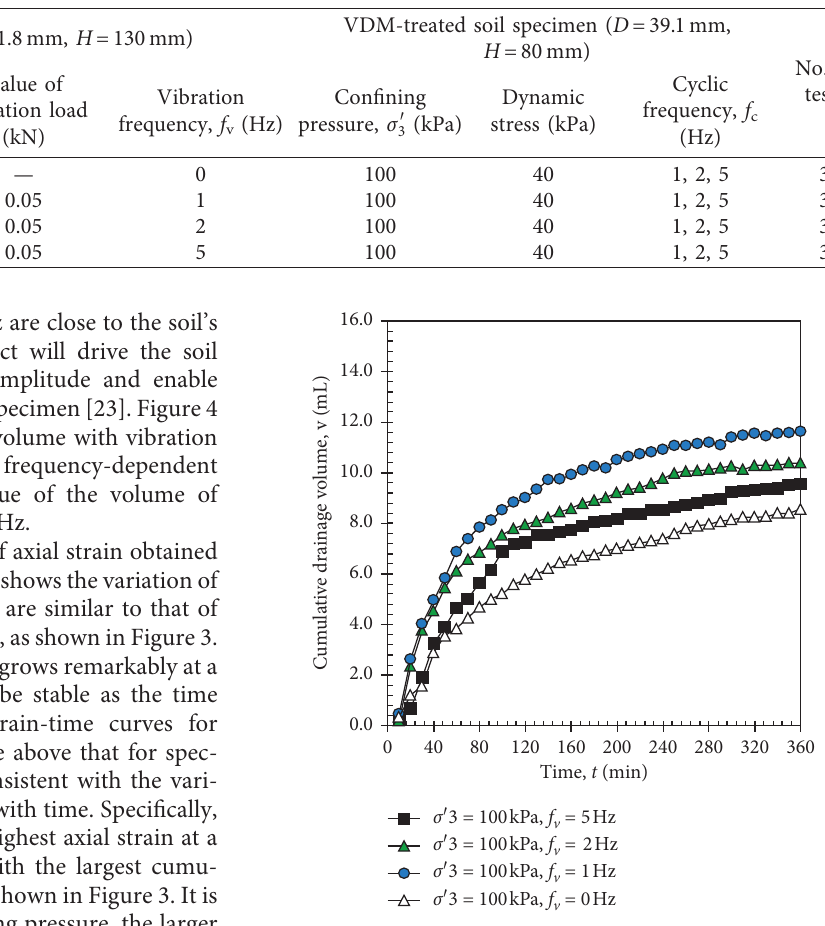
Table 1: Testing program.